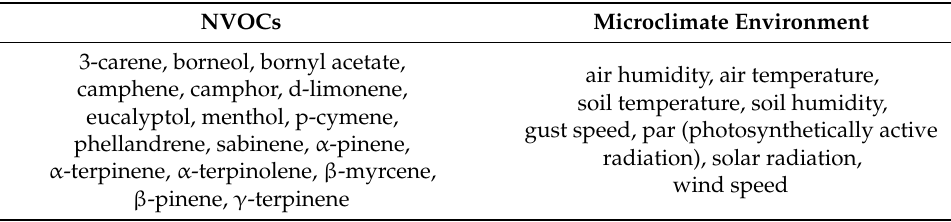
Table 1. NVOCs and microclimate environment measurement factors.